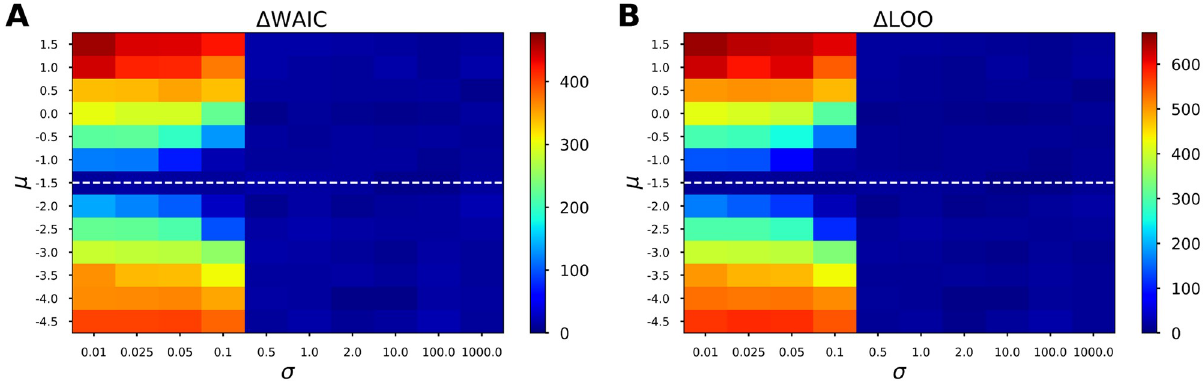
Fig 3. Effect of the parameters of a Gaussian prior on the performance of WAIC and LOO in selecting the epileptogenicity hypothesis for the 2D Epileptor model. To illustrate how fully Bayesian information criteria are affected by the parameters of a Gaussian prior placed on the excitability parameter, Delta scores for WAIC and LOO are computed as a function of the mean and the standard deviation of prior. Panels ( A ) and ( B ) show the computed Δ WAIC and Δ LOO, respectively, when the prior placed on excitability parameter is a Gaussian distribution N ð m ; s 2 Þ , in which excitability value (denoted by μ ) varies from -4.5 to 1.5, whereas the uncertainty about the estimation (denoted by σ ) ranges from 0.01 to 1000. It can be seen that WAIC closely approximates LOO cross-validation. The figure plots the averages over 4 HMC chains. The dashed white line indicates the true value of excitability parameter used in the simulation. A larger value of WAIC/LOO indicates that the parameter is less plausible.